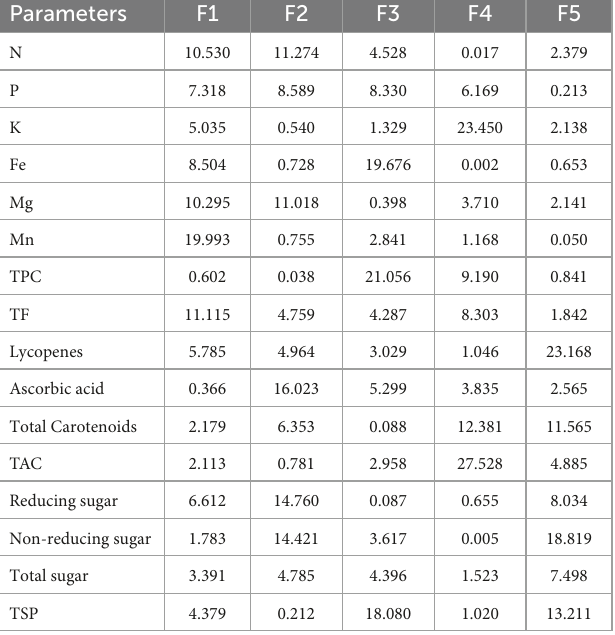
TABLE 6 Contribution of the variables (%) in different fruit peels.